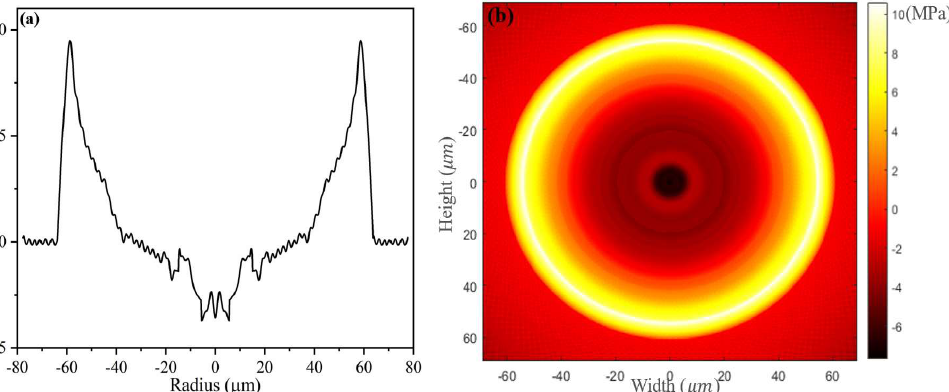
Figure 4. Actual measured residual stress distribution of Corning SMF-28: ( a ) one-dimensional distribution of axial residual stress; ( b ) two-dimensional distribution of residual stress in fiber cross section.